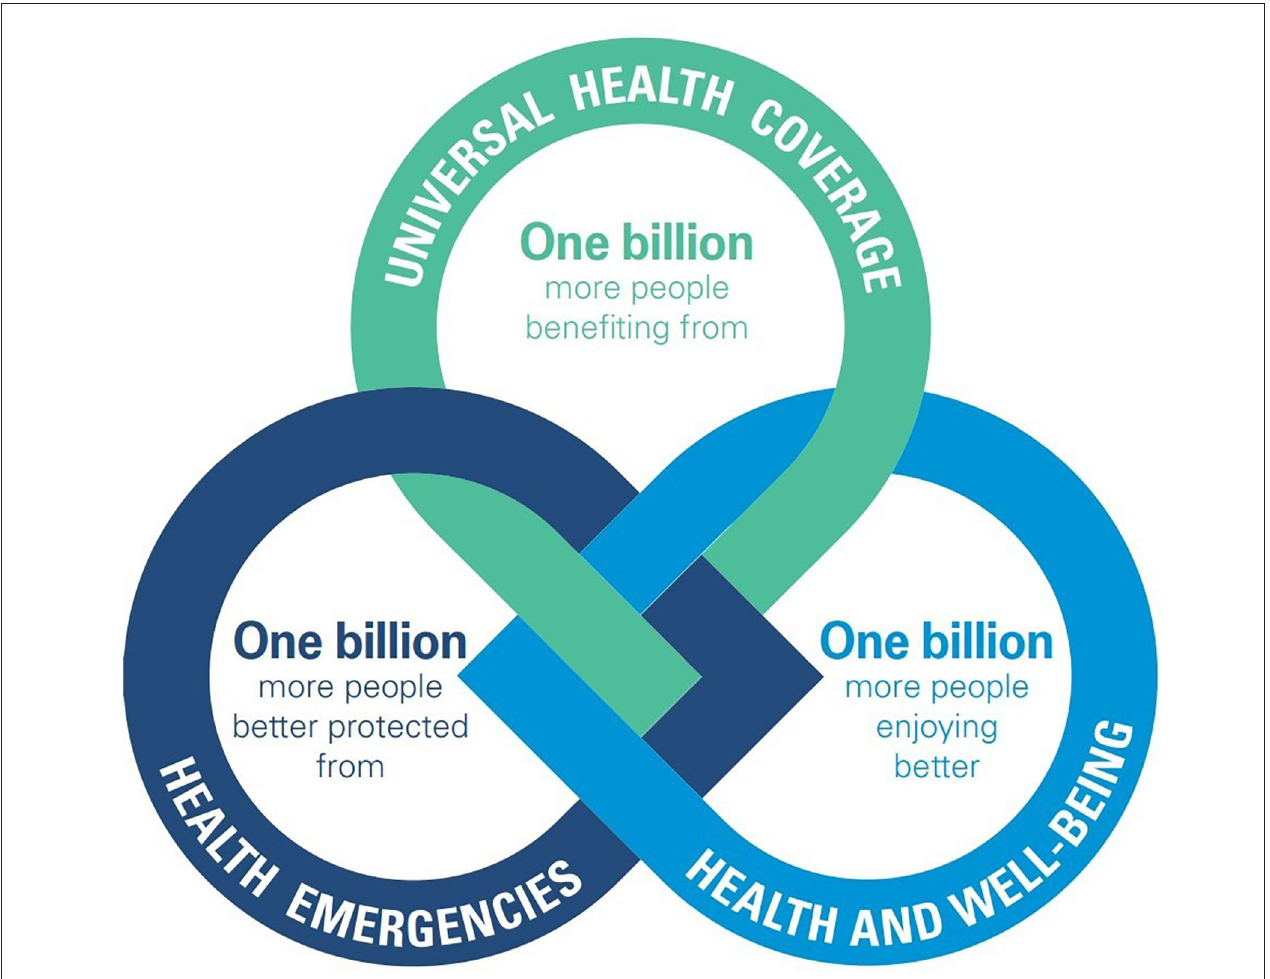
FIGURE 1 | The GPW13: a set of interconnected strategic priorities and goals to ensure healthy lives and promote well-being for all people at all ages. Source: GPW13 ( 2).